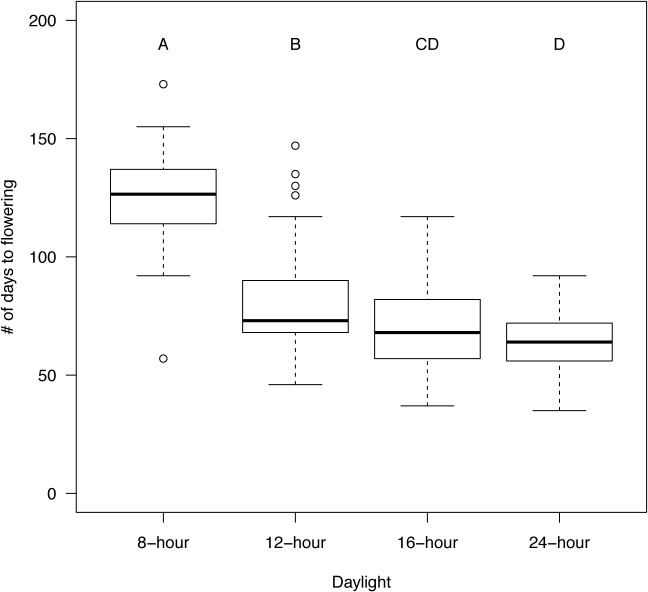
Flowering time is significantly increased in shorter days.Plants of eleven populations were grown in growth chambers at the indicated day lengths. The first day of flowering was defined as the day when the first flower opened or the inflorescence was 1 cm tall, whichever occurred first. ANOVA, followed by Tukey post hoc testing was performed for the combined data set of all populations of A. suecica (N = 270; data for all individual populations can be found in S3 Fig). Treatments not connected by the same letter are statistically significantly different. (For general boxplot description see Fig 4.)